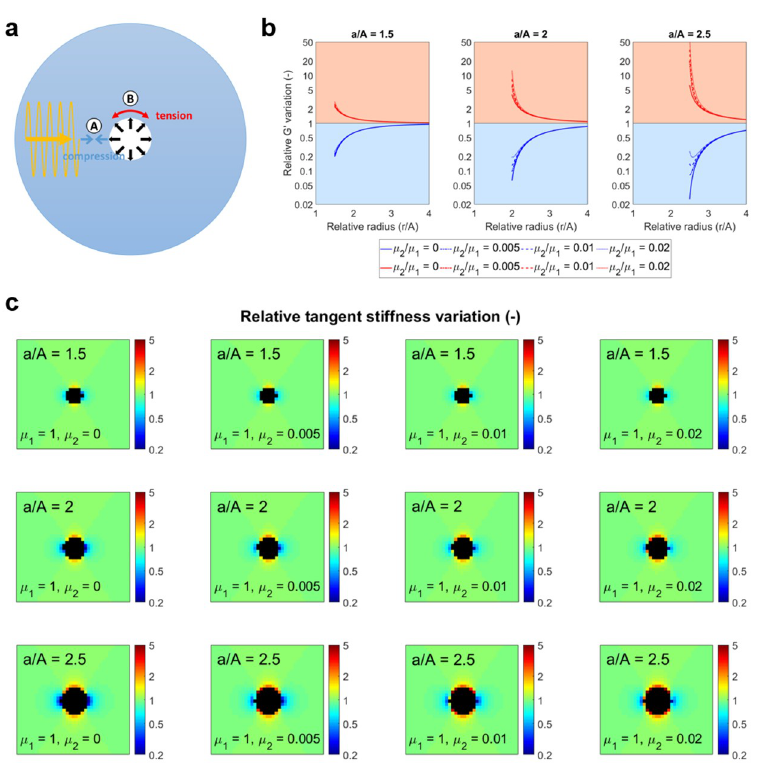
Fig 6. Modelling the mimicked tumour-generated pressure. (a) Wave propagation through the thick-shelled sphere. Due to the local spherical coordinate orientation, at Ⓐ , the wave will appear as θ -polarised, travelling in the radial direction. At Ⓑ , the opposite is found. (b) When the waves approach the inner sphere head-on, inflation leads to an apparent softening of the material (blue curves in the blue region). In contrast, along the peripheral interface of the inner sphere, a stiffening is detected (red curves in the red region). Given a constant μ 1 = 1, the parameter μ 2 shapes the curves differently in the two regions, especially in the case of larger deformations (larger a / A ). The relative G 0 variation is given in logarithmic scale. (c) 2D representation of the shear modulus variation patterns generated by an inflated inner sphere as probed by plane waves propagating from left to right.